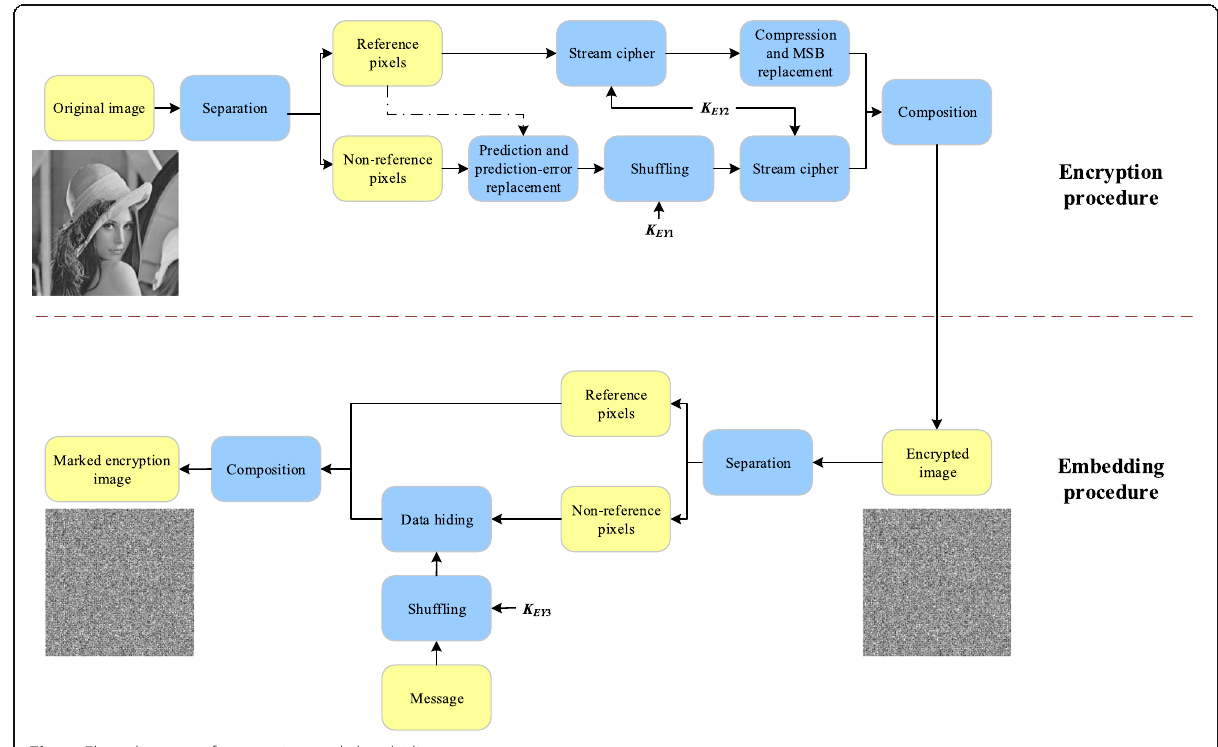
Fig. 1 Flow diagram of encryption and data hiding